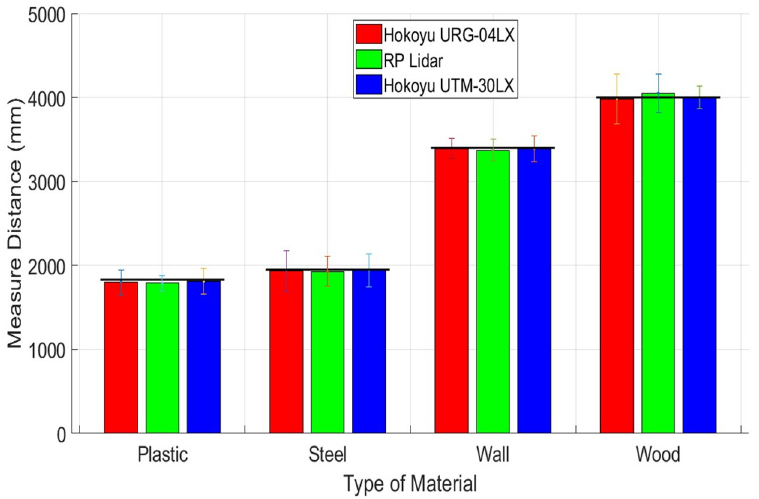
Fig 18. Plot of mean and standard deviation of each scanner by scanning different targeted